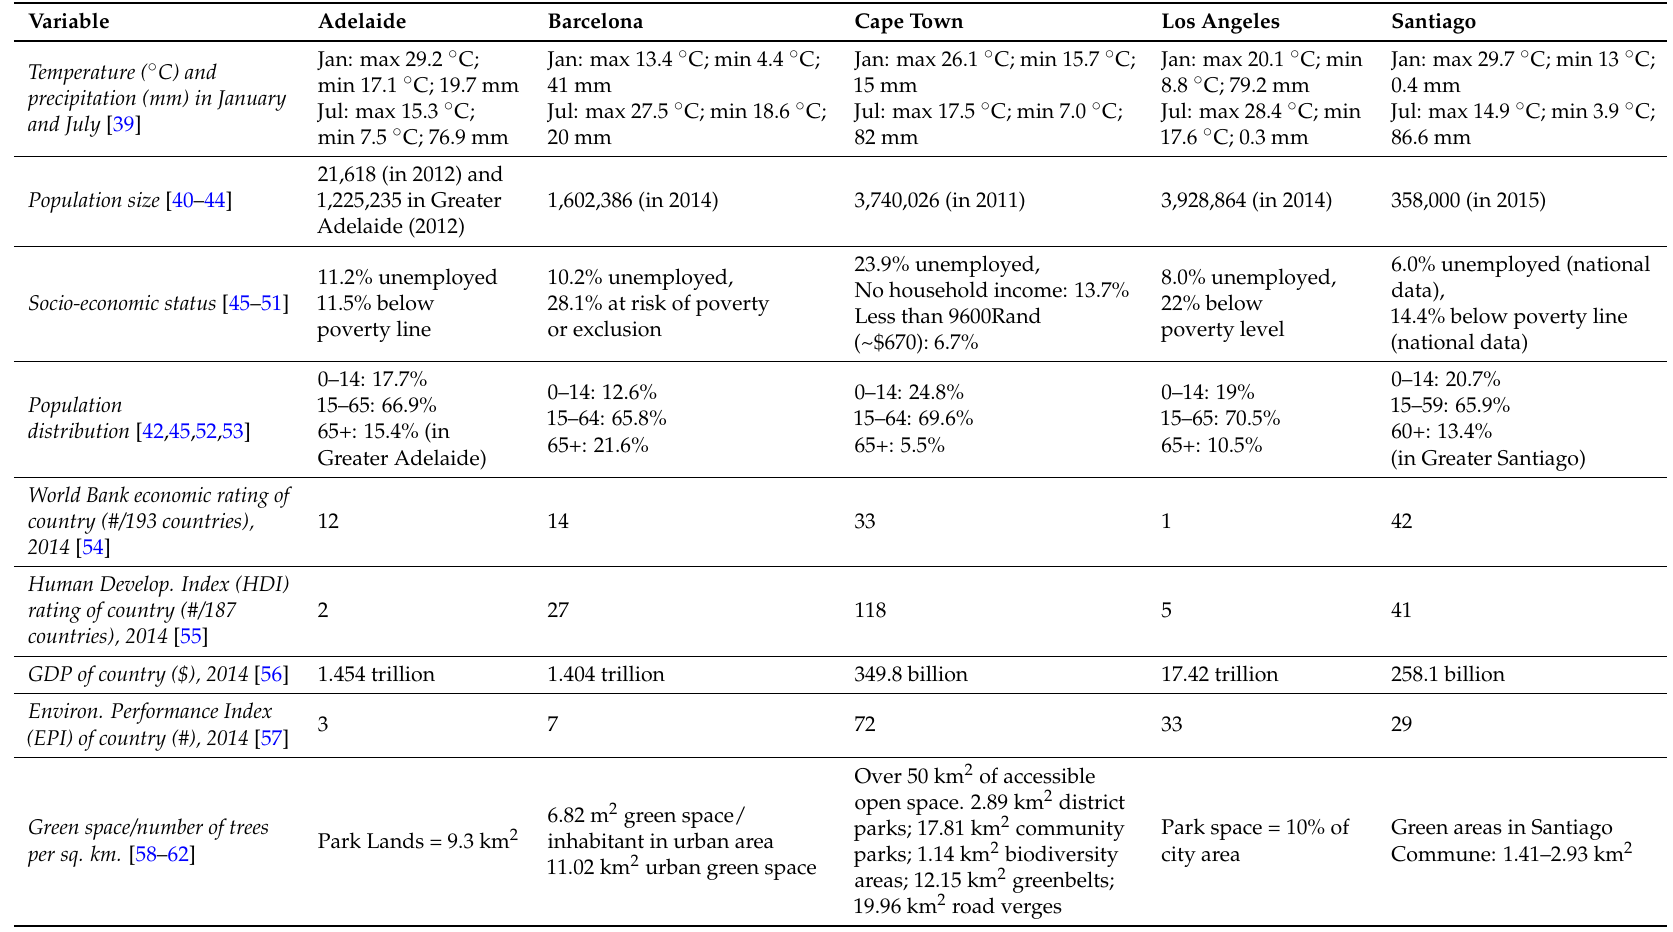
Table 1. Descriptive data on the five selected